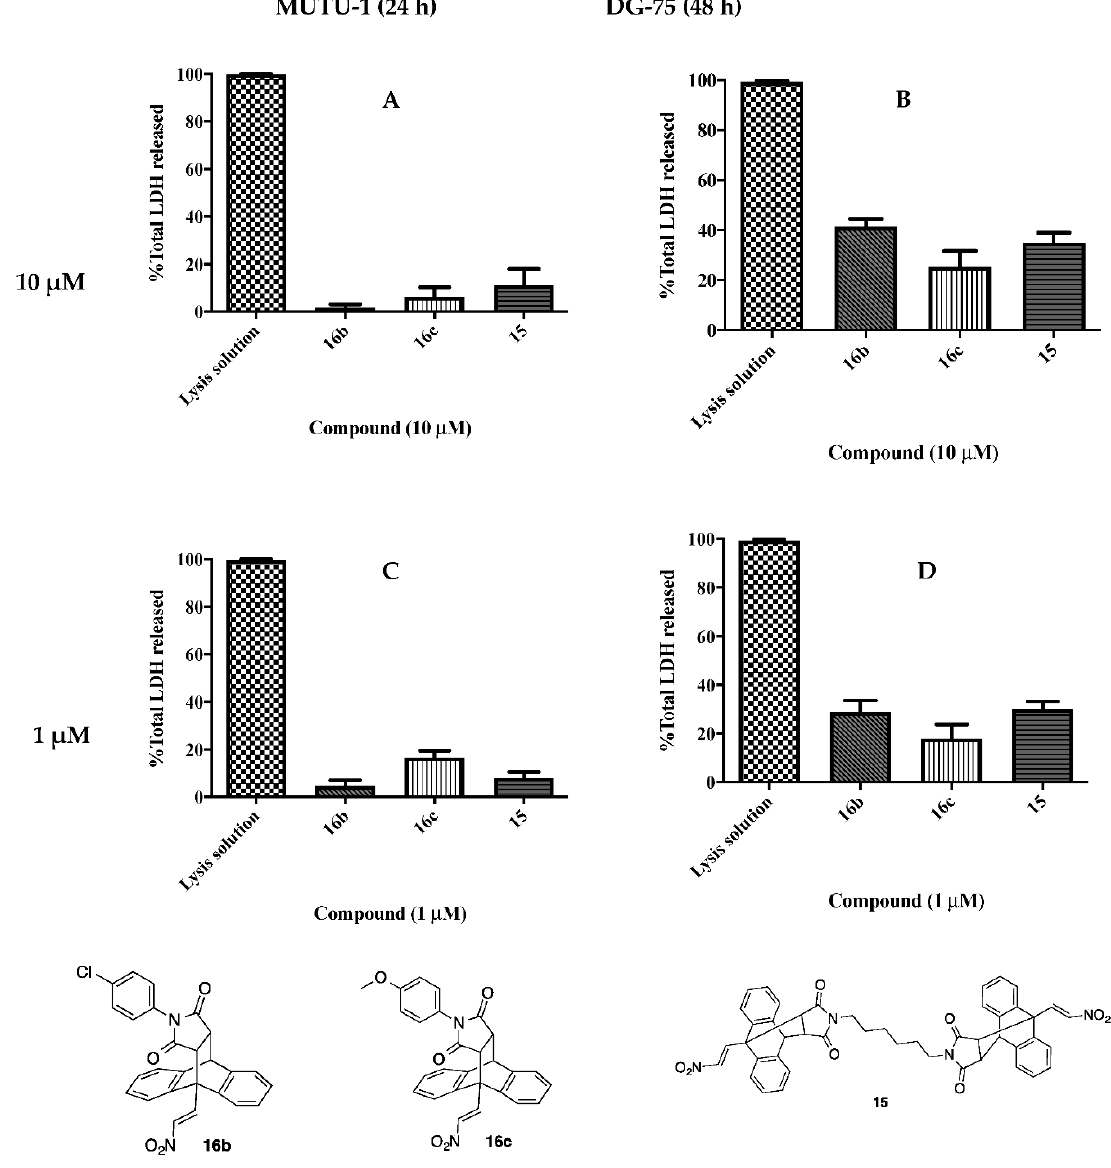
Figure 6. Lactate dehydrogenase (LDH) assay of ethanoanthracenes 15 , 16b and 16c . Cells were treated with ethanoanthracene compounds 15 , 16b and 16c (1 µ M and 10 µ M) for 24 or 48 h. Induction of necrotic cell death was determined by measuring LDH release in MUTU-I ( A , C ) and DG-75 cell lines ( B , D ), with control lysis solution (100% necrosis). Values are shown the mean of three independent experiments.